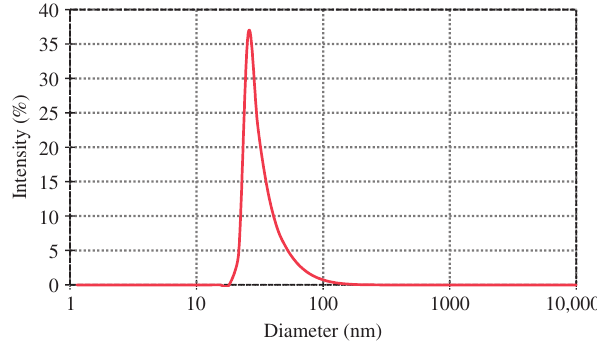
Figure 8: Size distribution of synthesized AuNPs at obtained optimum synthesis conditions.